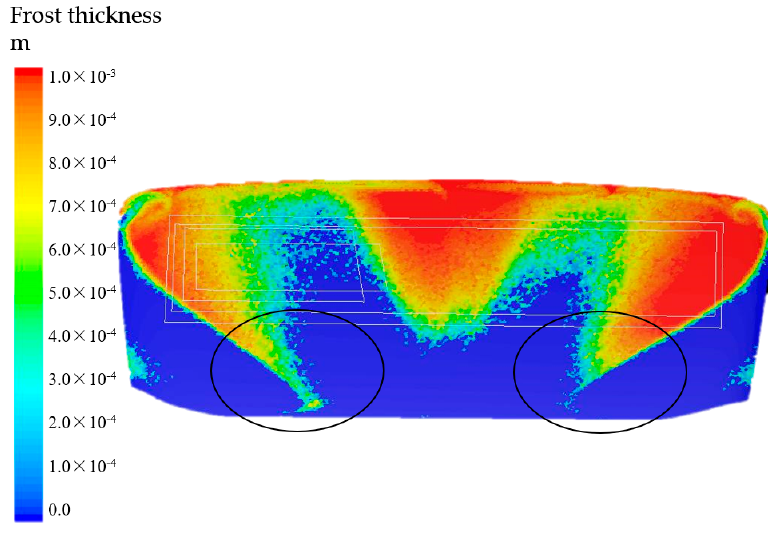
Figure 6. Frost thickness of the windshield surface at 25 min.